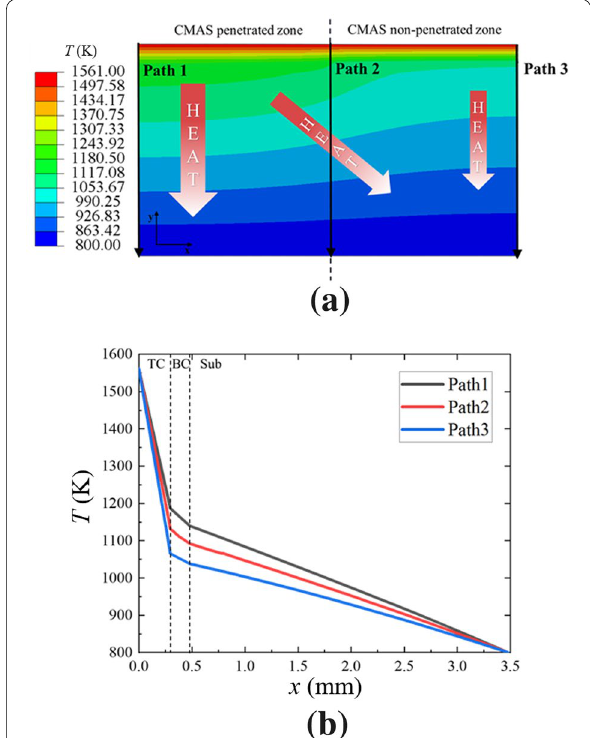
Figure 4 ( a ) Temperature distribution of multi-period global model of APS TBCs under non-uniform CMAS penetration, ( b ) temperature distributions along three paths in